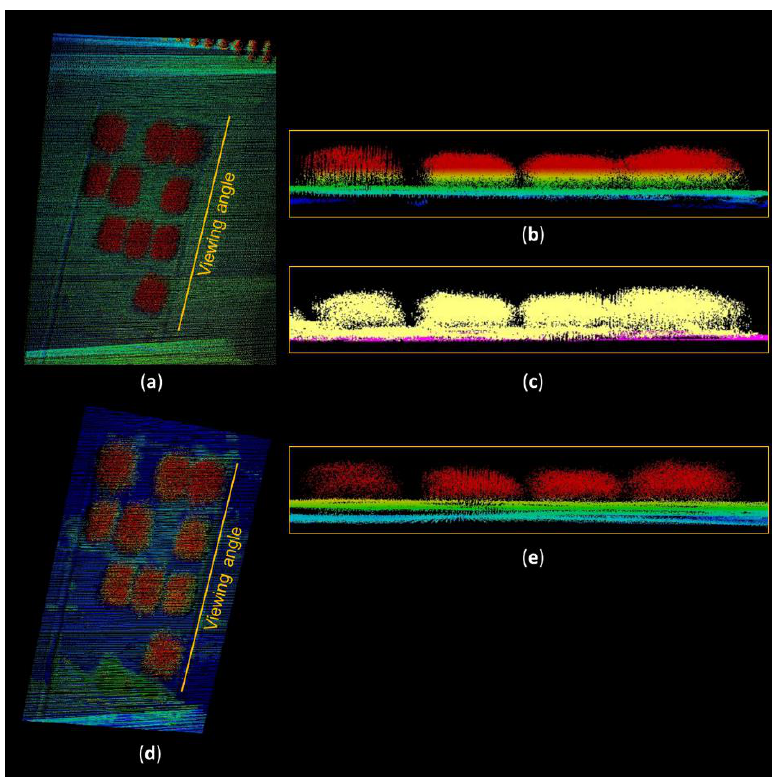
Figure 5. Rasterized three-dimensional (3D) light detection and ranging (LiDAR) point clouds before and after they were processed according to the workflow outlined in Figure 4. 3D LiDAR point clouds before the removal of outliers from ( a ) orthographic and ( b ), frontal view (presentation in the Y-Z plane); ( c ) visual distinction between the ground surface and plant canopies from the frontal view: the purple indicates ground and yellow indicates plants; ( d , e ) 3D LiDAR point clouds after the removal of outliers from the orthographic and frontal views, respectively (presentation in the Y-Z plane).